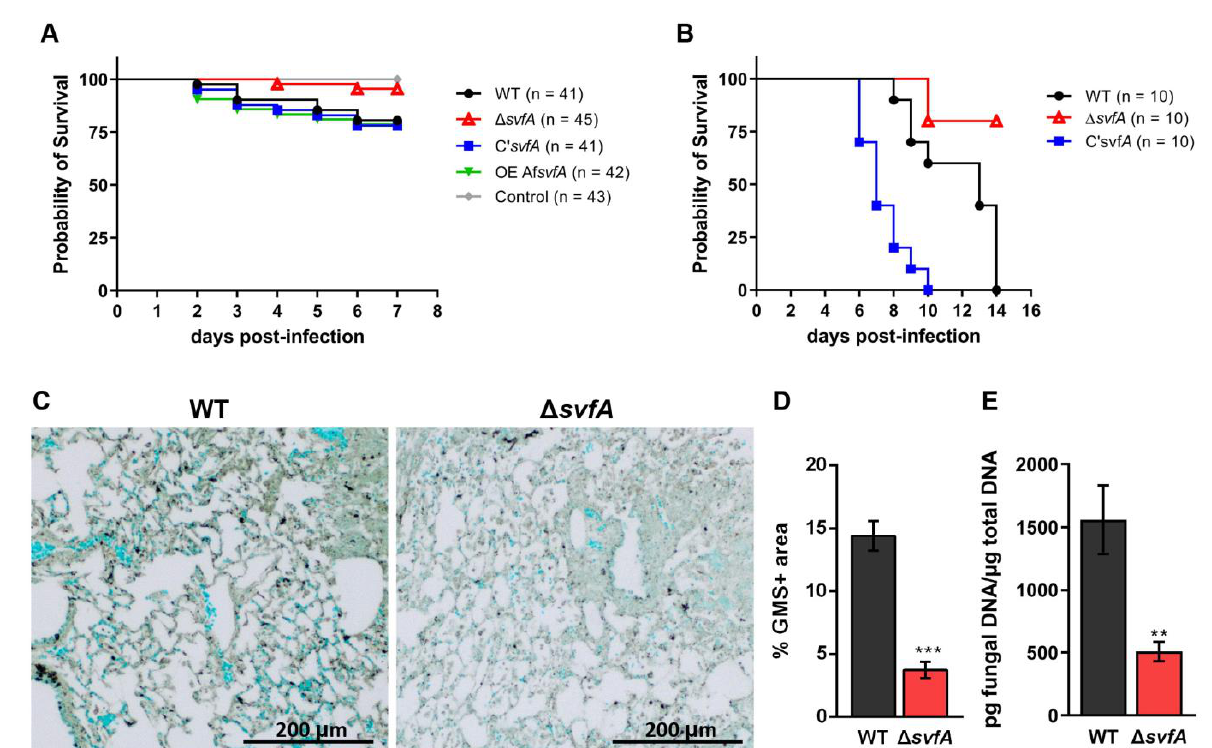
Figure 7. Severity of A. nidulans strains in animal models. ( A ) Survival rate of the T-cell-deficient zebrafish larvae ( foxn1 morphant) infected with A. nidulans conidia. Conidia were diluted in fluorescent dye to observe the injection site and injected into 3 d post-fertilization larvae (0 dpi). Control represents the injection with only dye. N = 41 – 43/group ( B ) Survival rate of the CGD mice (gp91 phox-/- mice) infected with A. nidulans conidia. N = 10/group. ( C ) Representative lung GMS staining. The lung was harvested from the CGD mice infected with WT or Δ svfA conidia at 5 dpi. ( D ) Fungal burden determined from GMS staining of adjacent lung sections. *** p < 0.001. ( E ) Fungal burden determined by quantification of fungal DNA from conidia-aspirated lung homogenates. N = 4/group. Data are a summary of two independent experiments. ** p <